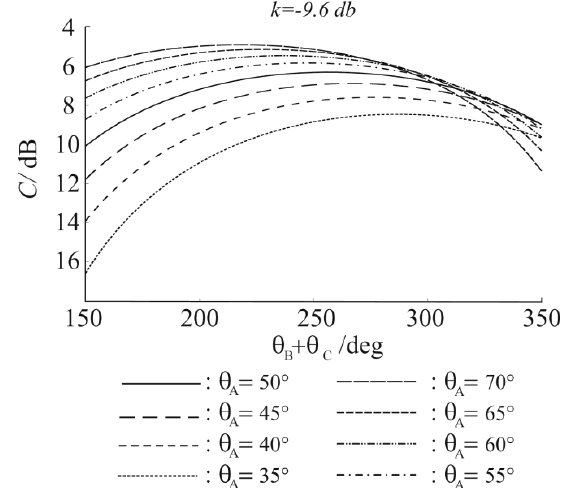
Figure 3. Coupling C of the directional coupler in Figure 2.